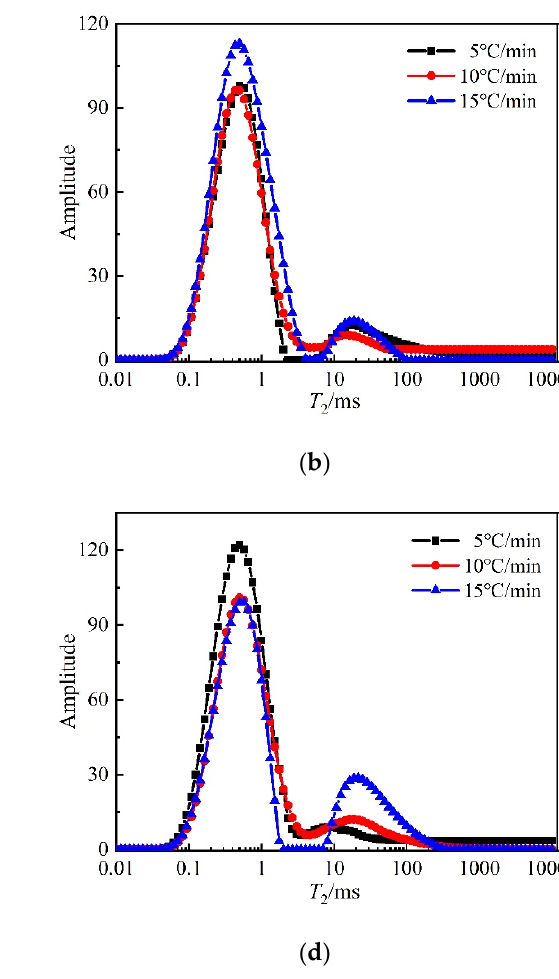
Figure 12. NMR T 2 relaxation time distributions of mortar: ( a ) 60 °C; ( b ) 400 °C; ( c ) 500 °C; ( d ) 600 °C.